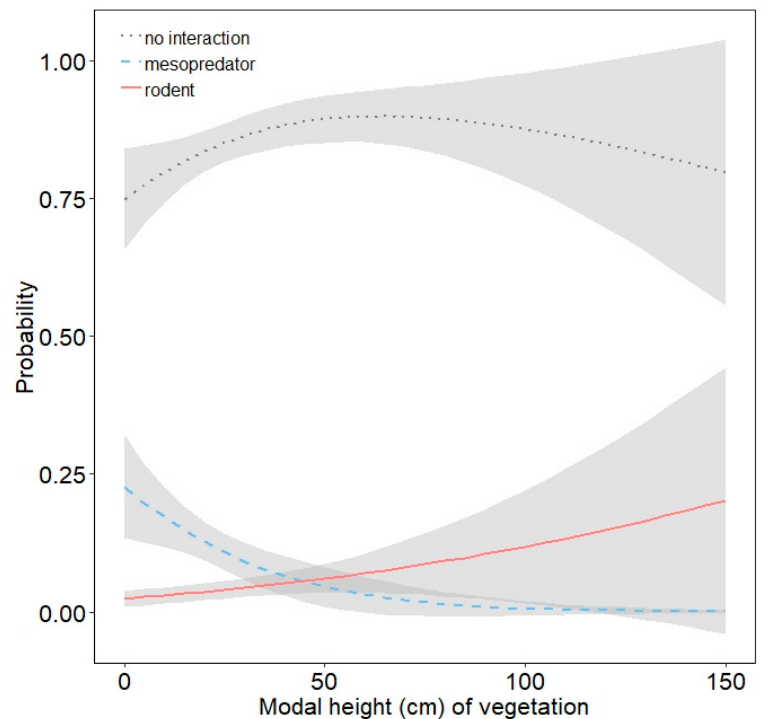
Figure 7. Probability with 85% confidence interval of mesopredators and rodents interacting with three-dimensional printed turtle models (or no interaction) as a function of modal vegetation height (cm) around models.